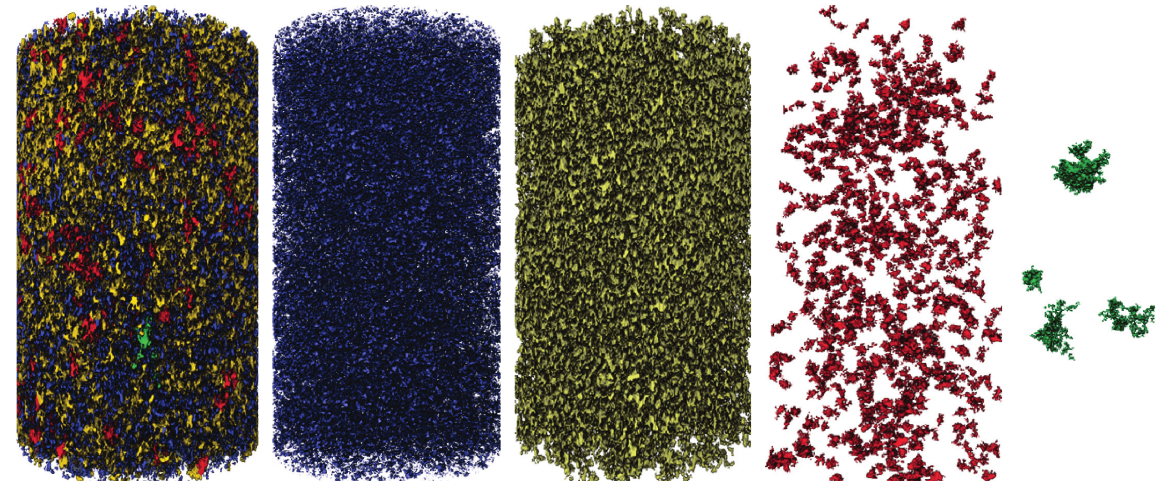
Figure 8: Spatial distribution of the pore structure of sample C-S-1.